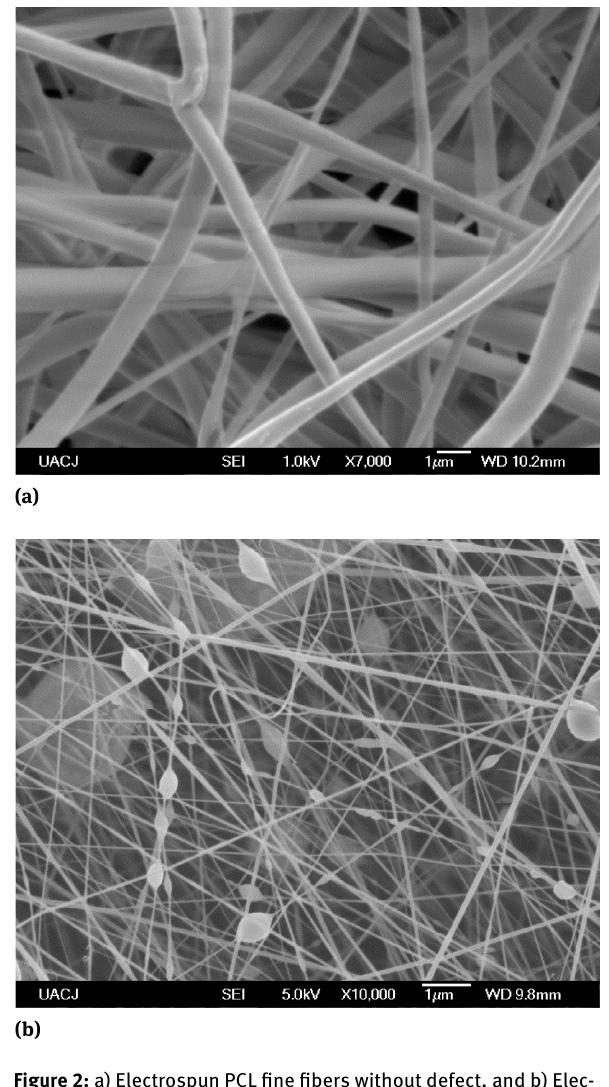
Figure 2: a) Electrospun PCL fine fibers without defect, and b) Elec- trospun PCL fibers with like-beads